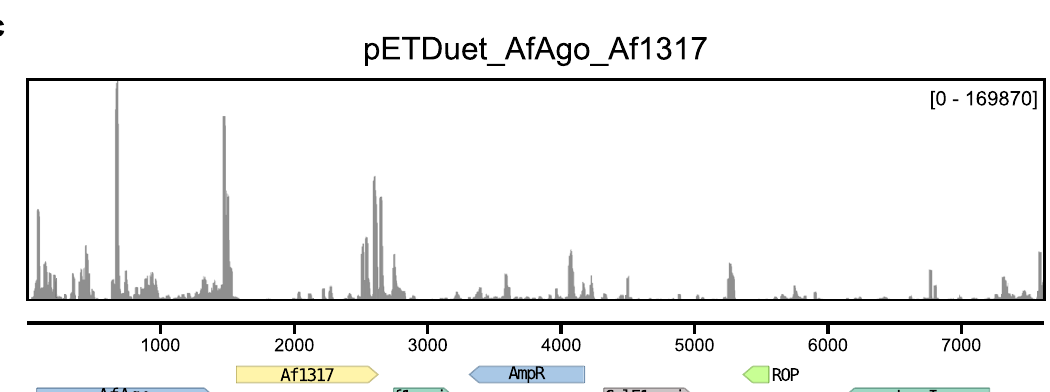
Figure 1. Analysis of in vivo ( E. coli ) AfAgo-bound nucleic acids. ( a ) Top-Digestion of AfAgo nucleic acids with DNAse I and RNase A. Bottom-Size analysis of AfAgo-bound RNA. ( b ) Read length distribution of sequenced AfAgo-bound nucleic acids. ( c ) Sequencing read alignments to the AfAgo expression vector. 73% of all reads map to the expression vector, compared to 27% to E . coli genome (Supplementary file 1). ( d ) Small RNAs copurified with AfAgo show 5 ′ -AUU